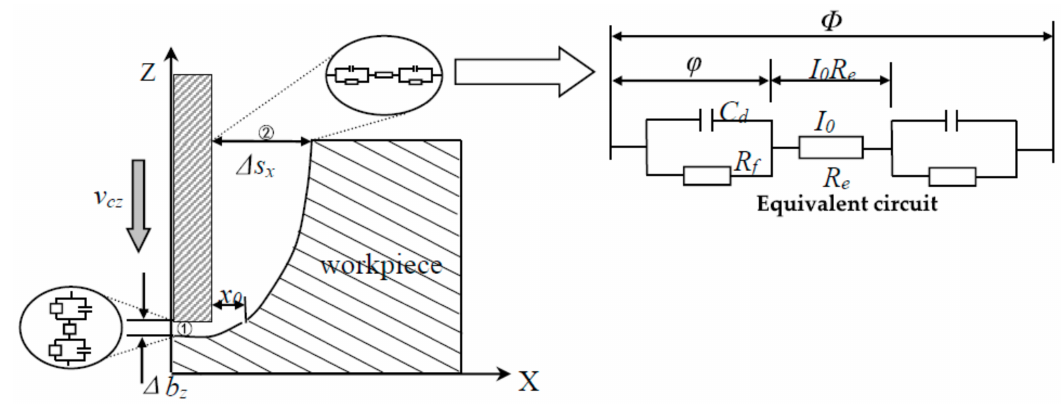
Figure 2. Sketch of feeding